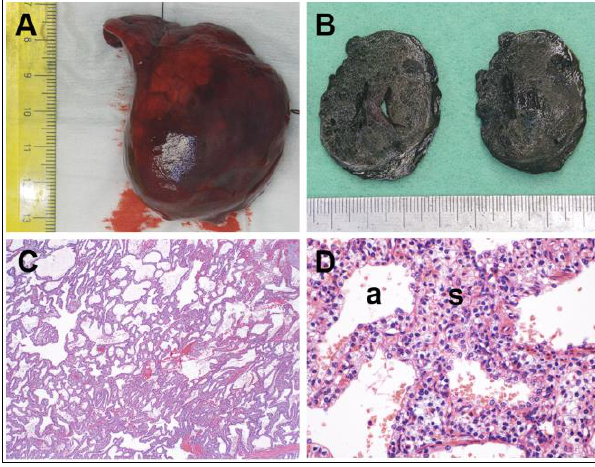
Figure 3: Pathological features of Case 2. A. Right lower lobe resection containing a well-circumscribed tumor. B. On section- ing, the tumor exhibited a solid and cystic cut surface. C and D. Low power (C) and high power (D) view of the tumor (hematoxylin and eosin stained sections) showing airspaces (a) lined by bland cuboidal cells and surrounded by thickened septa (s) containing an infiltrate of cells with clear